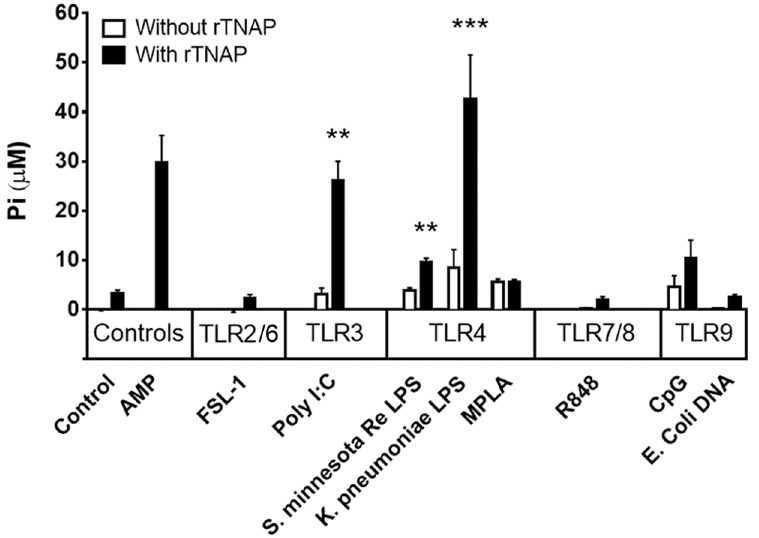
Fig 1. Human TNAP, the predominant AP of human plasma, dephosphorylates select TLR3 and TLR4 agonists. N = 3–7, each TLRA evaluatedin at least 3 independentexperiments, two-tailedStudent’s t-tests. ** p < 0.01, *** p < 0.001.